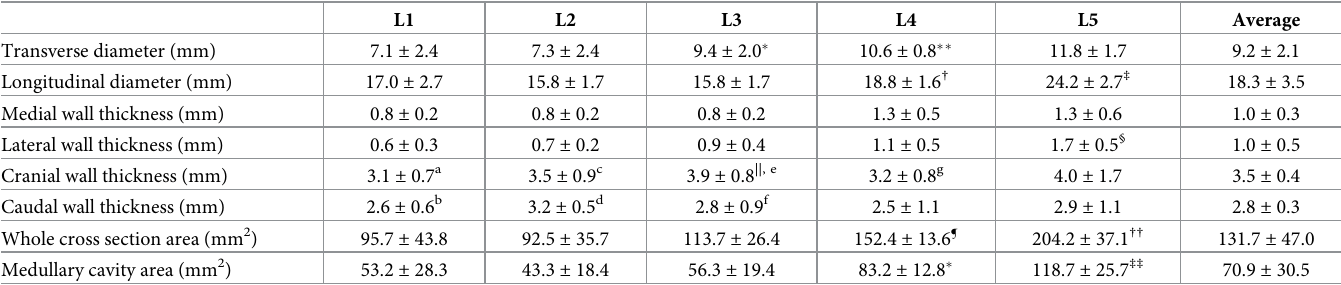
Table 2. Pedicle dimensions.